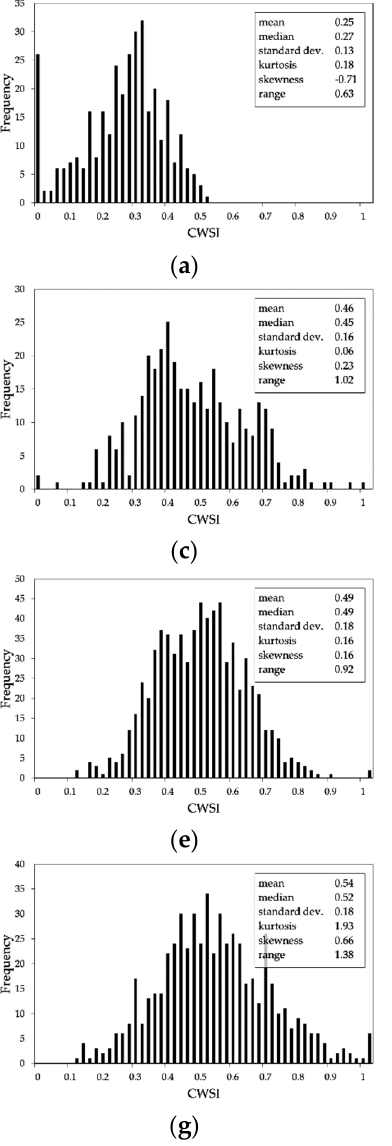
( b ) SSMZ 2; ( c ) SSMZ 3; ( d ) SSMZ 4; ( e ) SSMZ 5; ( f ) SSMZ A; ( g ) SSMZ B; ( h ) SSMZ